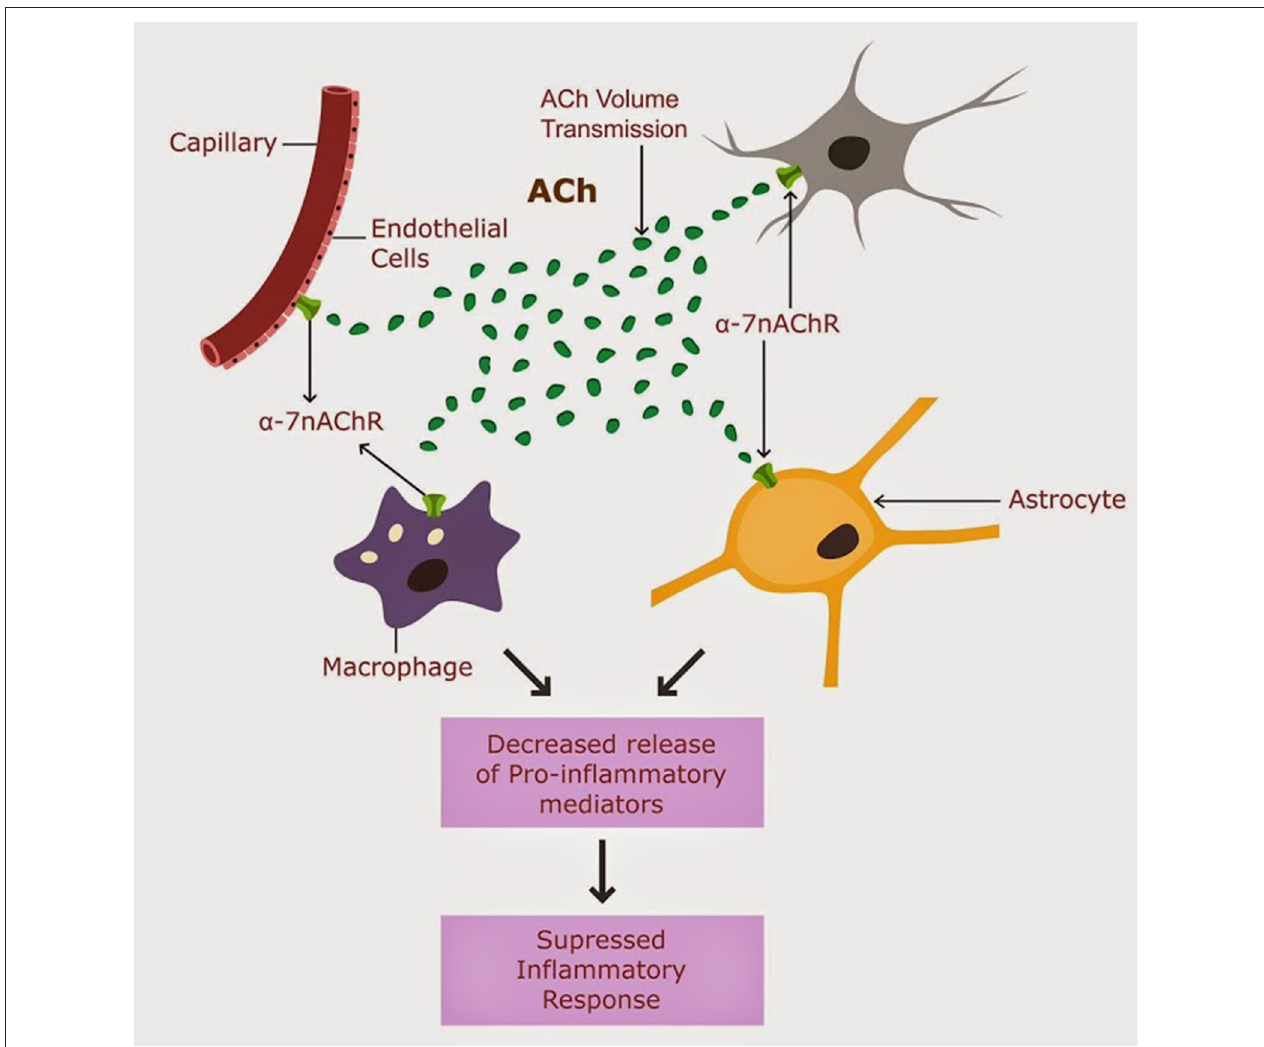
FIGURE 1 | CAIS is operational in the CNS, and involves ACh action of alpha 7 nAChRs expressed on astrocytes, neurons, microglia and brain macrophages (Tyagi et al., 2010) .